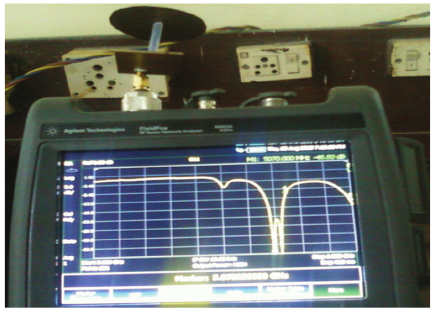
Figure 14: Hardware testing on Agilent